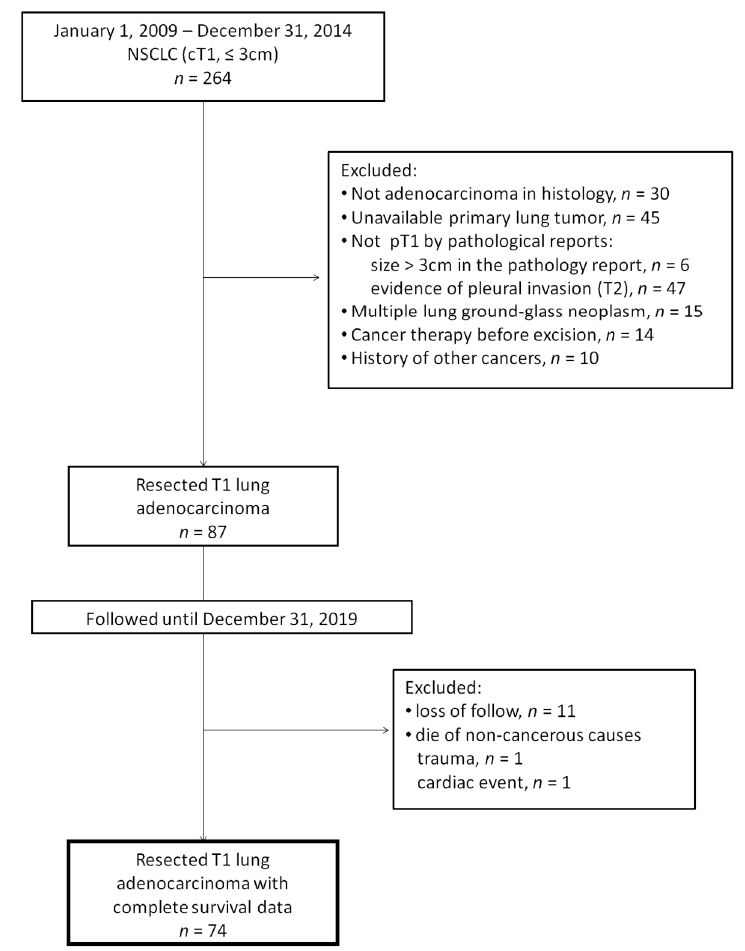
Figure 1. Consort diagram. NSCLC: non-small cell lung cancer; cT1: clinical stage T1; pT1: pathological stage T1.